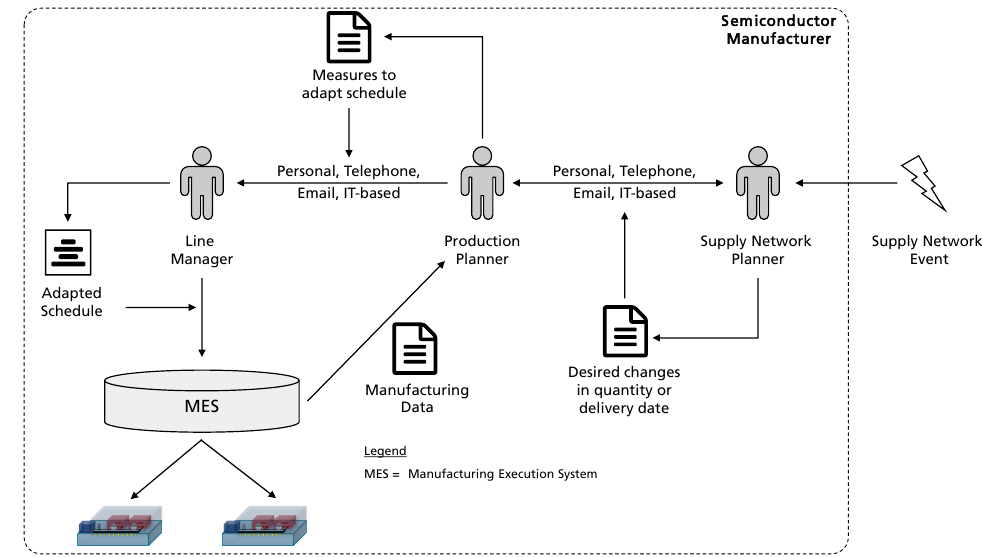
Figure 8. Exemplary process for responding to supply network